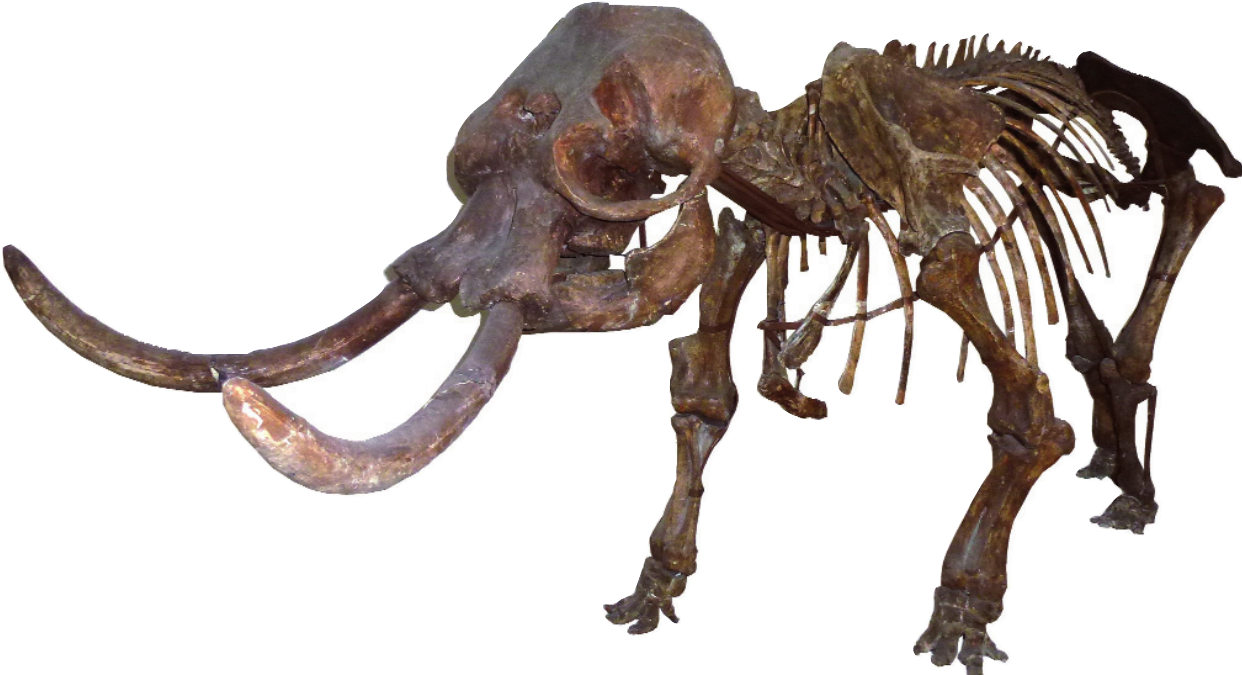
Figure 2. Composite skeleton of a dwarf elephant ( Elephas falconeri ) (Paleontological Museum of Rome